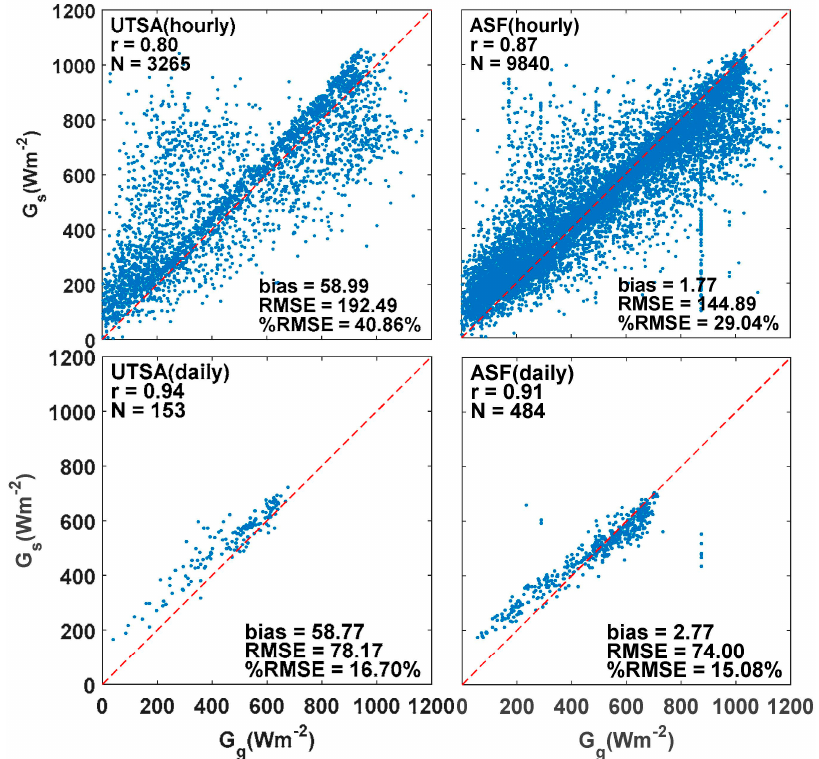
Figure 3. Scatter plots showing the correlation of G s versus G g on hourly and daily timescales for all-sky conditions at UTSA ( left panel ) and ASF ( right panel ) with the corresponding statistical parameters, r, bias, RMSE, %RMSE and N (number of observation pairs). The units of bias and RMSE are in Wm − 2 . The red-dash lines indicate the one-to-one lines.